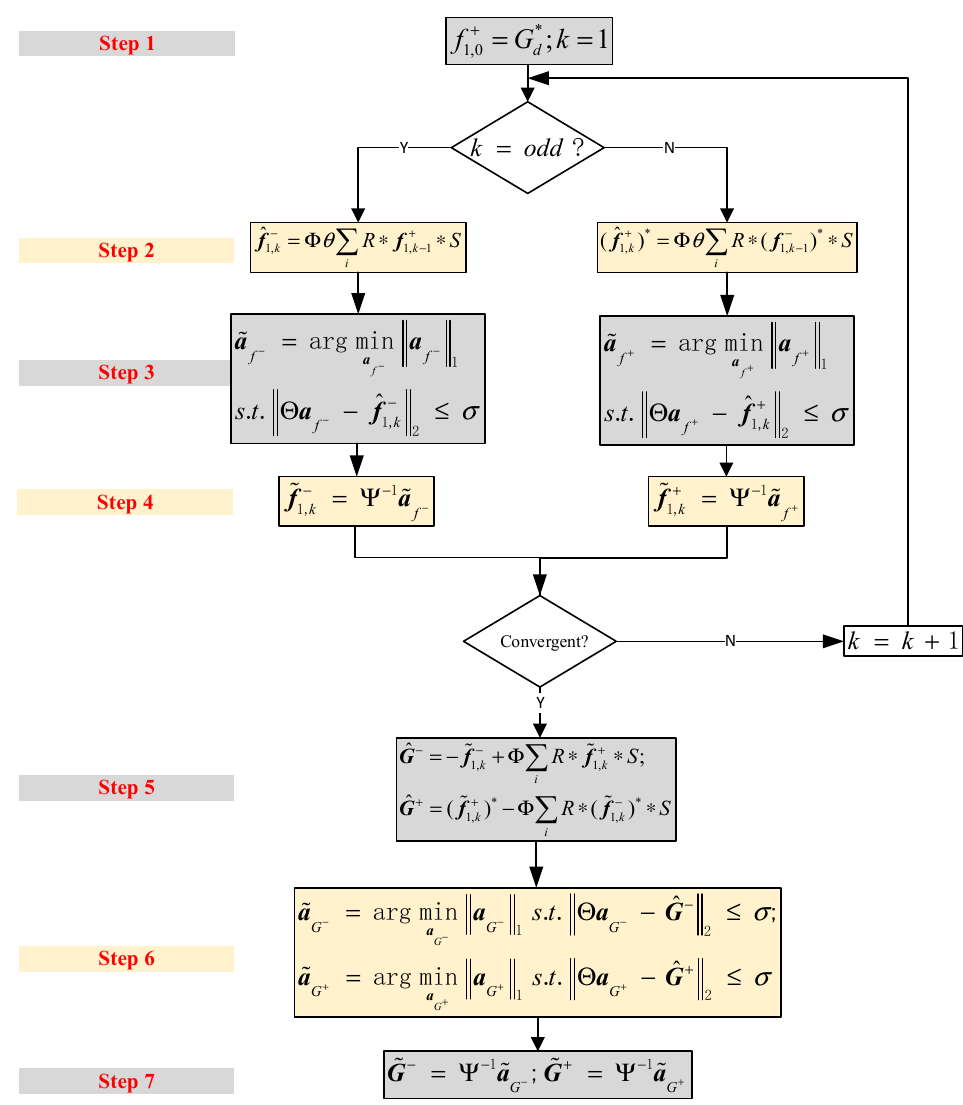
Figure 5. Workflow of the proposed Marchenko method. The focusing functions and Green’s functions are recovered by Steps 3, 4, 6, and 7. S is the source signal, k is the number of iterations, the superscript asterisk is the time reversal, the internal asterisk is the convolution or correlation, Φ is the sampling matrix, and θ is the time window